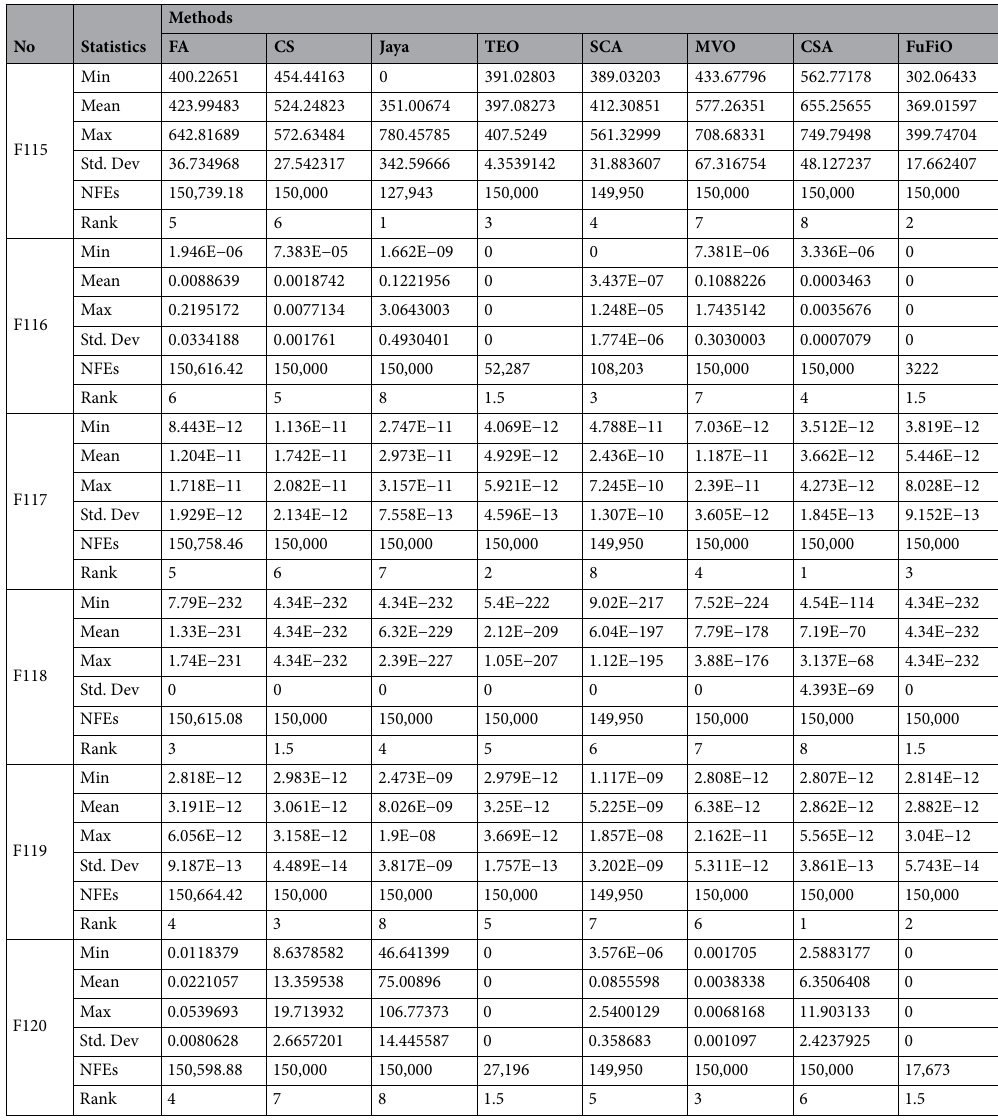
Table 6. Comparative results of algorithms for the N -dimensional functions.